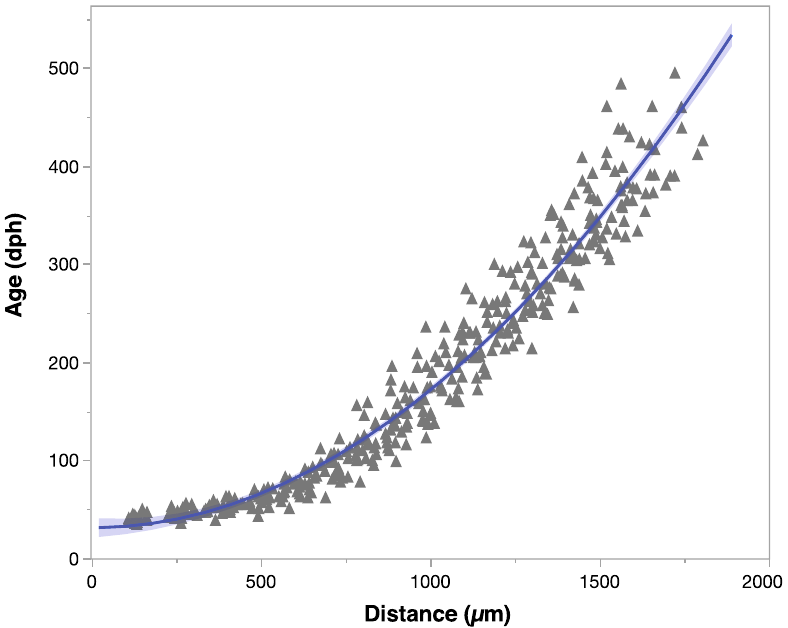
Figure 2. Relationship between distance from otolith core along laser scan and inferred age (days post hatch, dph) developed for 25 yearling Pacific bluefin tuna. Ages were predicted from calibrated composite images of transevers otolith sections from an earlier investigation 22 with interpolated age contours matched to distance measures at several distances along the laser scan path used in the current